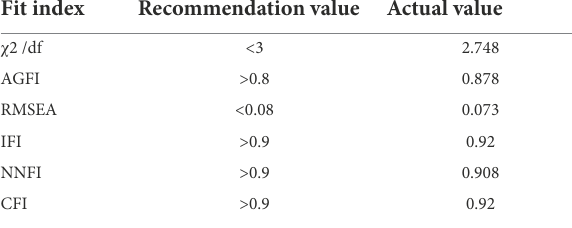
TABLE 7 Model fit indices.